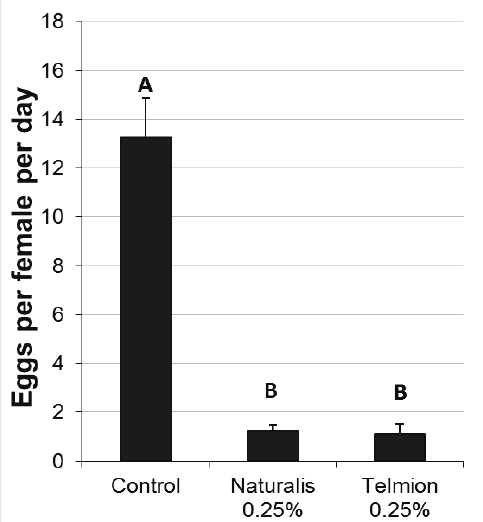
Figure 1. Oviposition reduction effect of Naturalis-L 0.25% and Telmion 0.25% in the laboratory experiment: Mean number of eggs per female per day (±se) in differently treated cherries. Different letters show significant differences (one-way ANOVA, Tukey HSD, α =